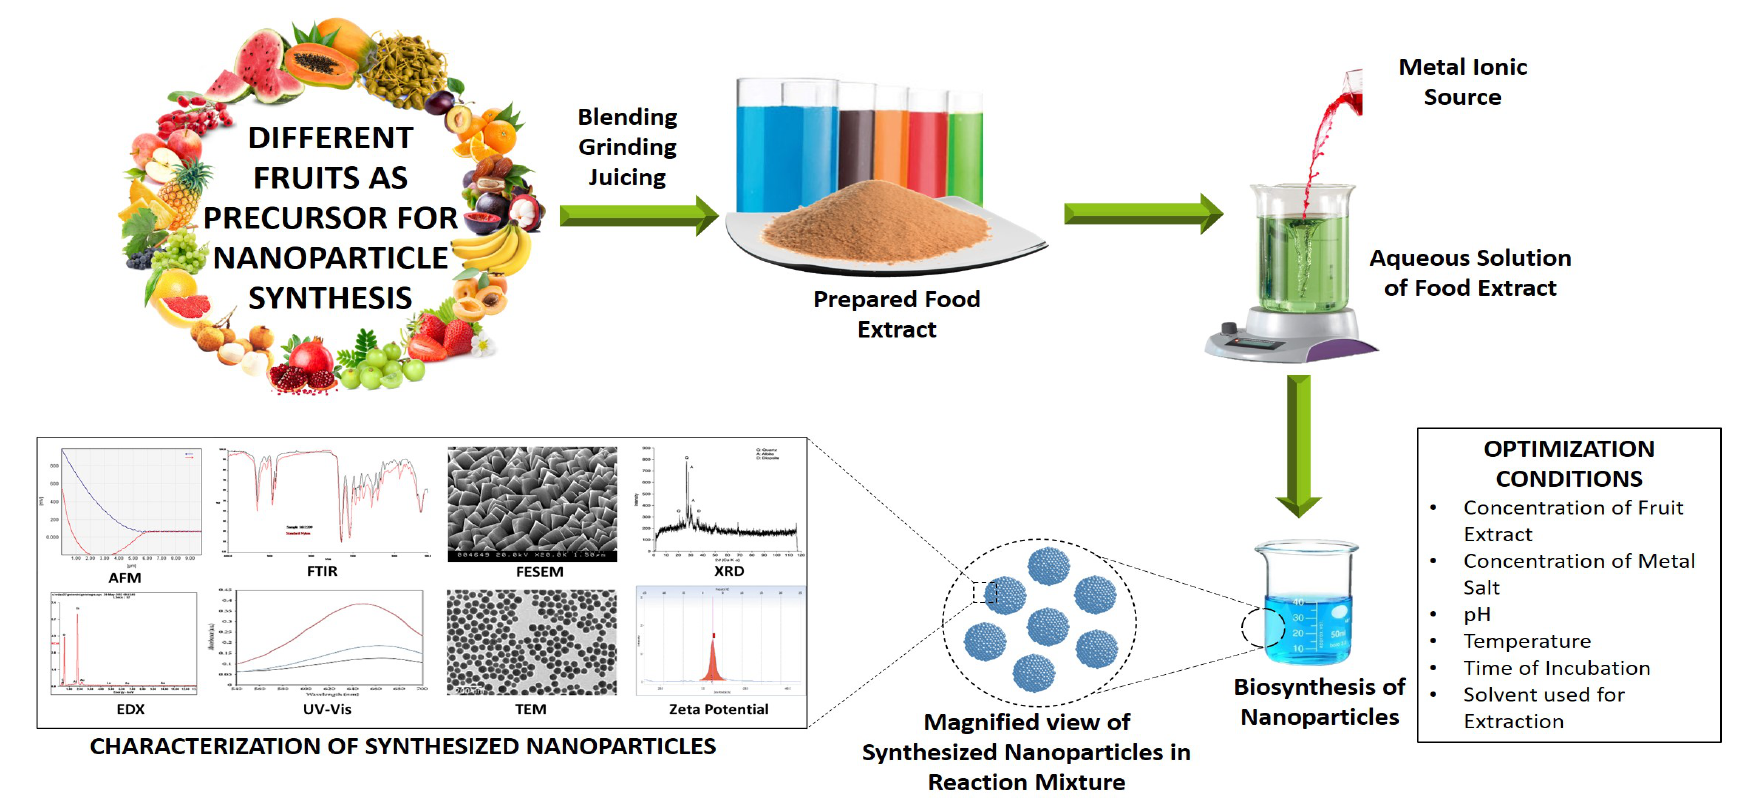
Figure 2. A general mechanism of nanoparticle formation from fruit extracts.